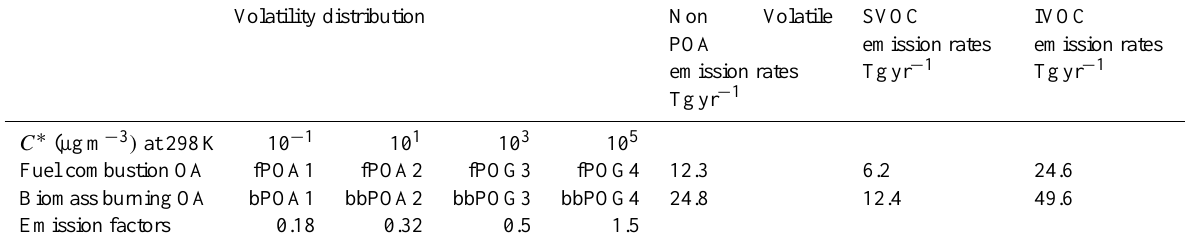
Table 4. Emission factors of the primary organic compounds from fuel combustion and biomass burning sources for each volatility bin used in ORACLE. The total global annual emission rates are also shown. The SVOC/IVOC emission rates are estimated by multiplying the emission factors of each bin by the nonvolatile emissions rates.